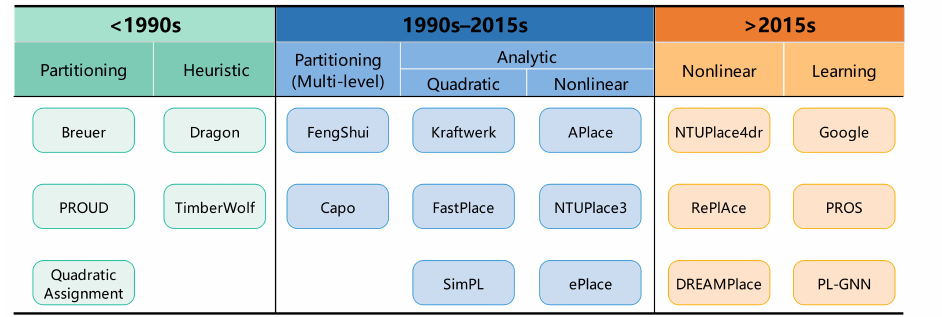
Figure 1. Description of placement algorithms and the corresponding placers in academia. As the design size increased, the dominant placement algorithms shifted from the early partitioning-based method to heuristic algorithms. Later, the partitioning method began prevailing again due to the application of the multi-level framework. In some recent academic contests, such as ISPD [3–7], DAC [8], and ICCAD [9–11], the analytical methods provided better results than the previous algo- rithms. Nowadays, the leading placers mainly use nonlinear rather than quadratic methods because of the higher quality obtained with nonlinear methods. Furthermore, learning-based algorithms are gaining more and more attention, and a well-known example is Google’s automatic macro placer [12]. Scholars have recently strived to achieve higher-quality placement results in less